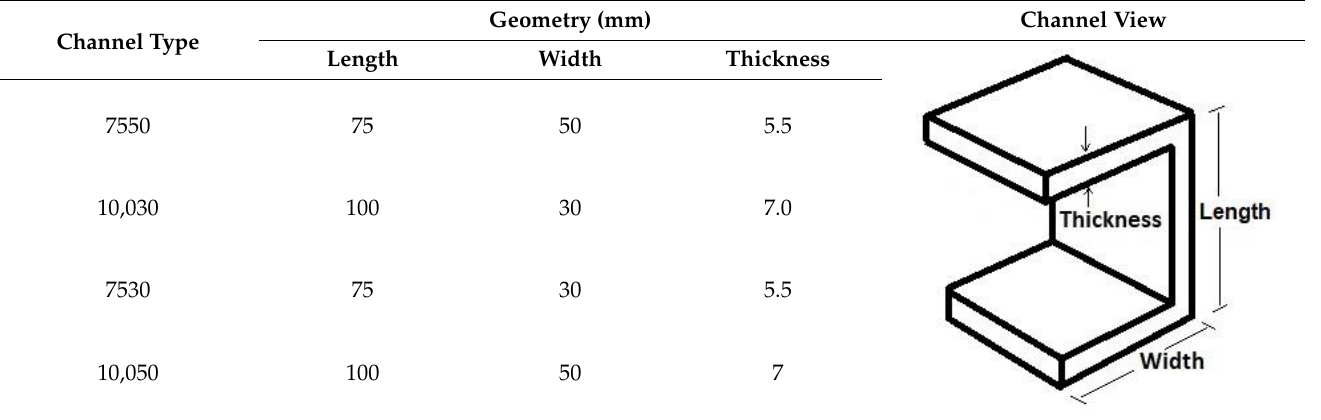
Table 1. Simulated channel geometric features.